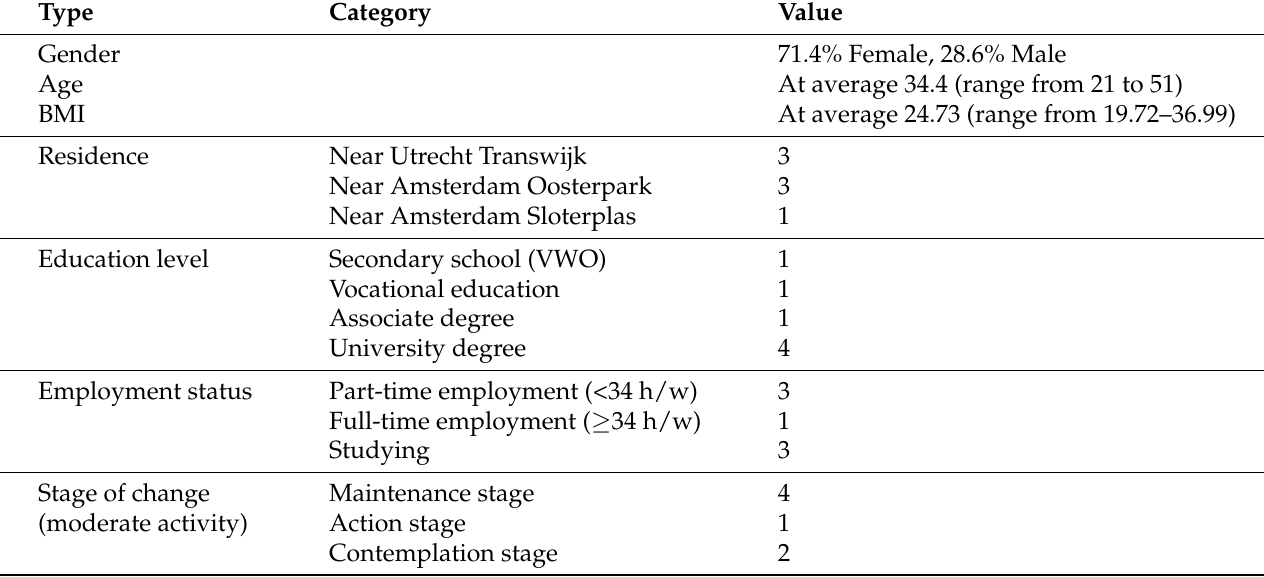
Table 1. The demographical information of 7 participants who completed the feasibility